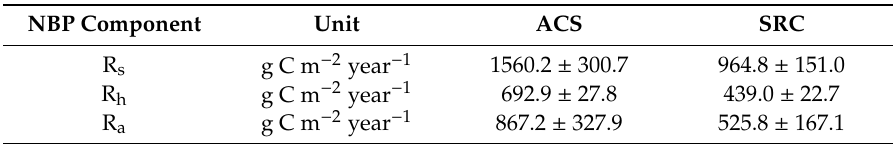
Table A4. Cumulated annual respiration rates in the two systems (g C m − 2 year − 1 , average ± SE; ACS: Alley Cropping System; SRC: Short Rotation Coppice system). Values reported as Soil respiration (R s ), Heterotrophic respiration (R h ), Autotrophic respiration (R a